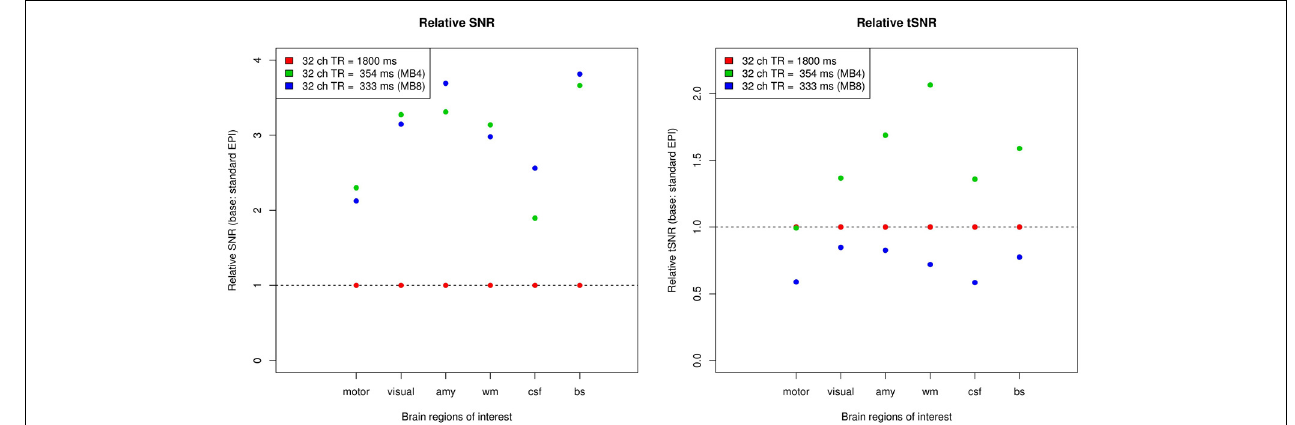
FIGURE 3 | Improving image SNR (left) and time-series SNR (right) via faster scanning. Although SNR per slice or volume is lower at lower TR , SNR per unit time is increasing due to more efficient scanning, as compared to TR = 1800ms. Furthermore, time series SNR is also improving, depending however on the brain region or